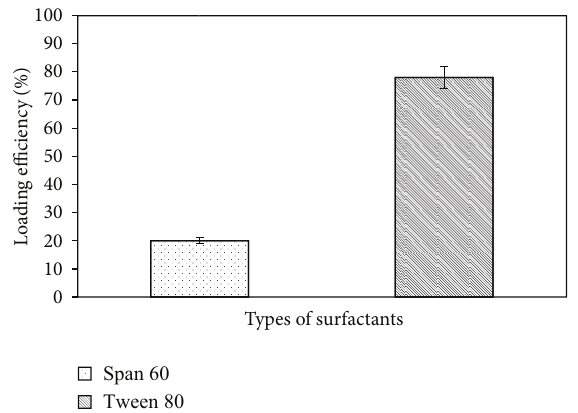
Figure 5: Effect of types of surfactant on loading efficiency of curcumin onto starch nanoparticles.